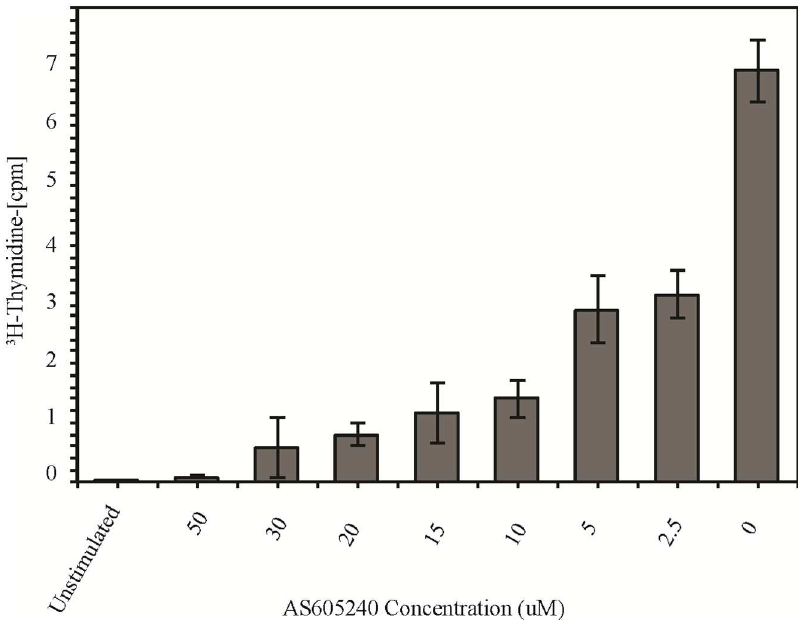
Fig 4. PI3K γ -inhibitor (AS605240) suppresseshuman autoreactive-T-cell activation. T-cell clone C-Gad 73 was stimulatedfor 72 hours with irradiatedHLADR401 + PBMC pulsed with GAD65 peptidein the presence of different concentrations of AS605240and without the drug. Unstimulatedcontrol represents the latter conditionwithout the peptide. Tritiated thymidinewas added for the last 8 hours and proliferation of the T-cell clone was determined.The columns represent the means +/- SE of three wells per AS605240concentration ( μ M). The y- axis rpresents the averagecounts per minute (cpm) of the DNA incorporation of tritiated ( 3 H)- thymidine.CPM are shown as 1/10,000 of actual count